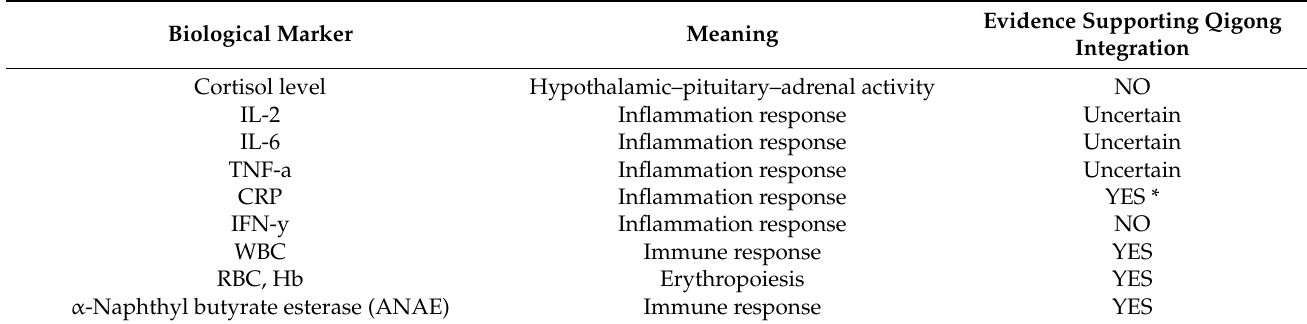
Table 5. Summary of evidence about biological